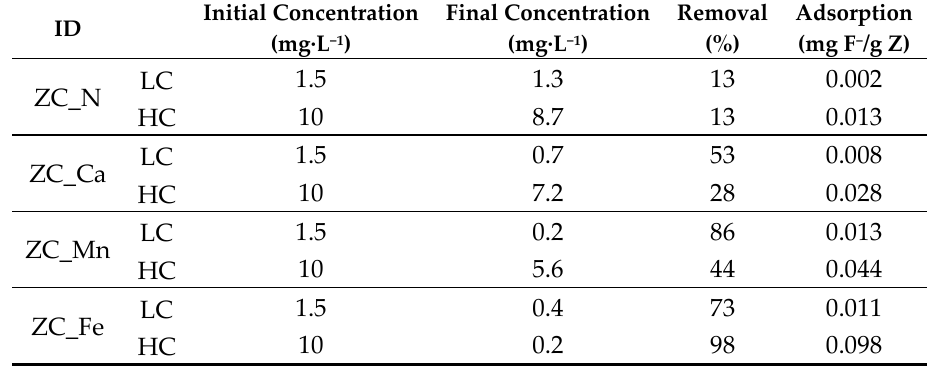
Table 3. Removal percentage and adsorption of fluorine ions with natural and conditioned